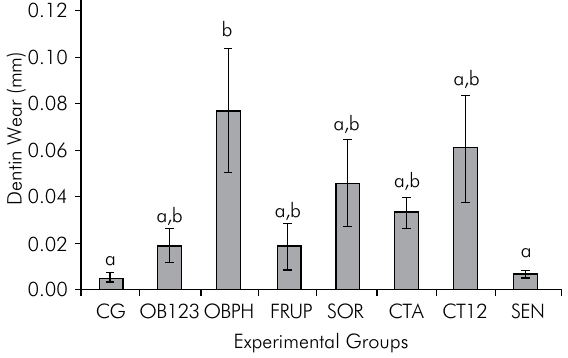
Figure 1. Mean values (± standard error of the mean) of surface loss (mm). Different letters indicate significant differences (p ≤ 0.05).